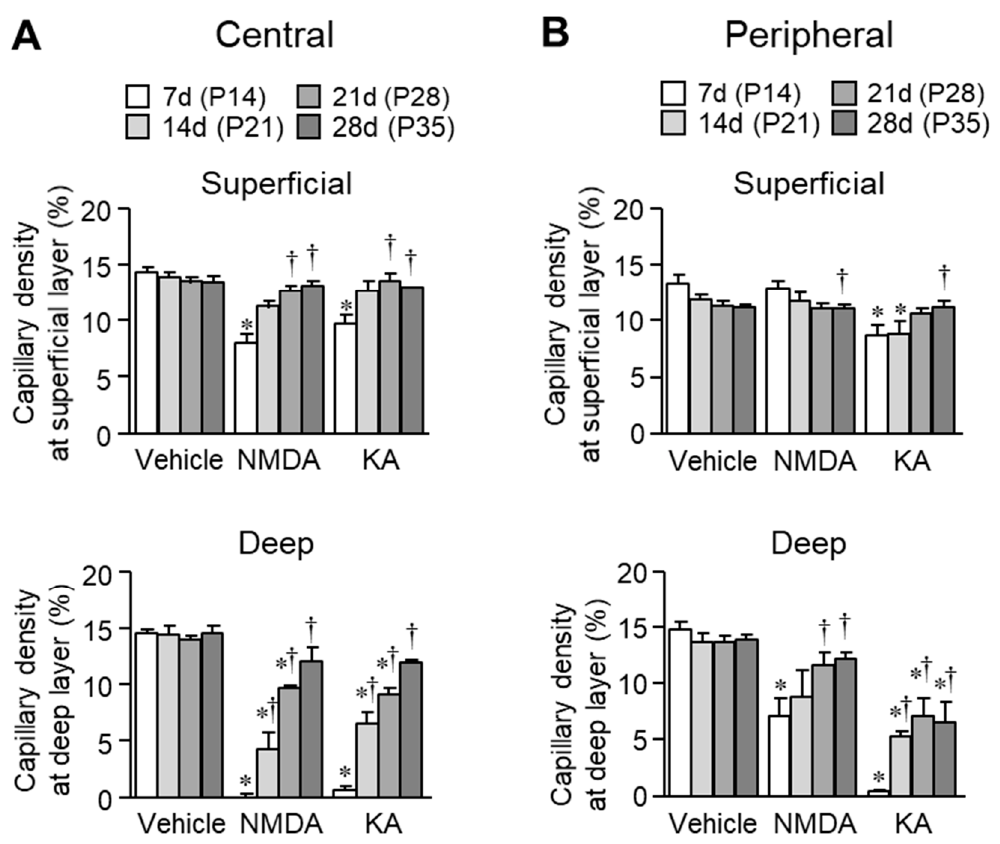
Figure 4. Quantification of area densities of the superficial and deep vascular plexuses in the central ( A ) and peripheral ( B ) retinal areas. * p < 0.05 vs. the corresponding age-matched control value (vehicle). † p < 0.05 vs. the corresponding seven days value after the injection. n = 4–5.